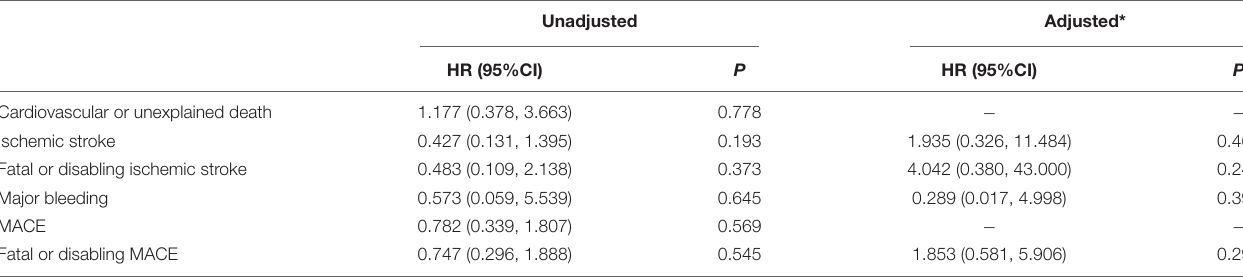
TABLE 4 | Multivariate Cox regression analyses between sex and outcomes in patients with age ≥ 65 years old. Unadjusted